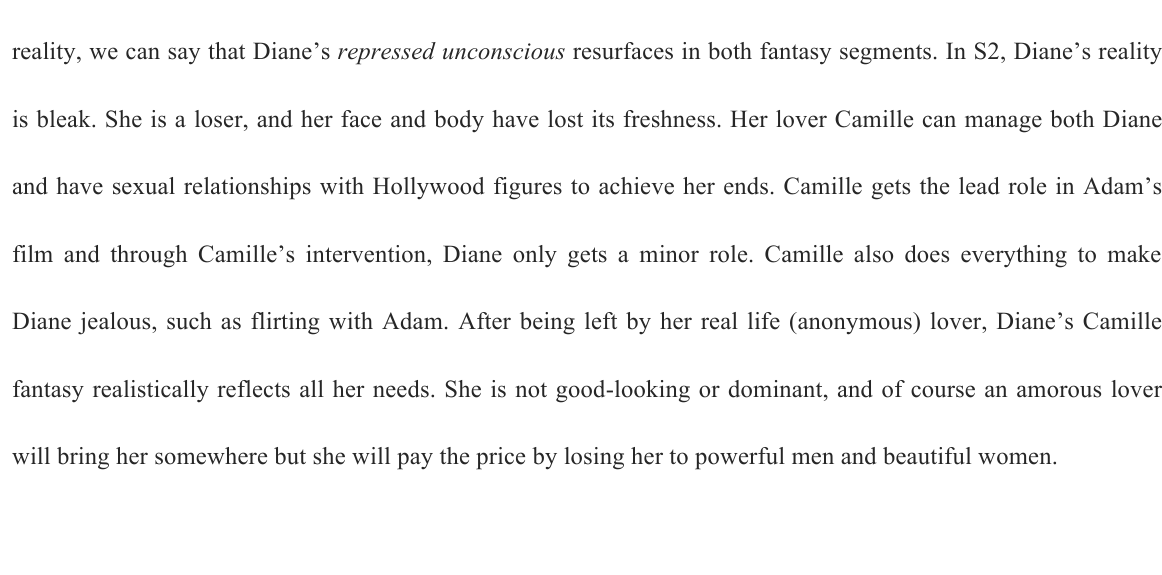
The Three Women: Elements of